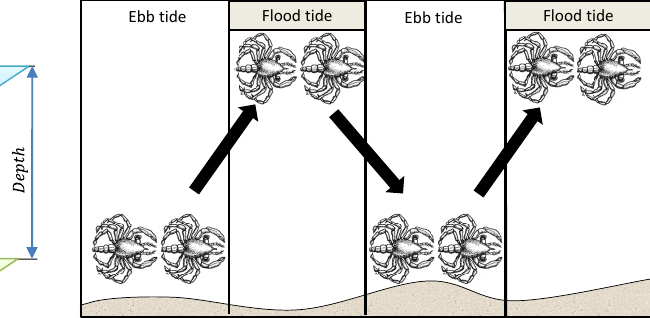
Figure 3: Profiler “braking” mechanisms and coordinates.